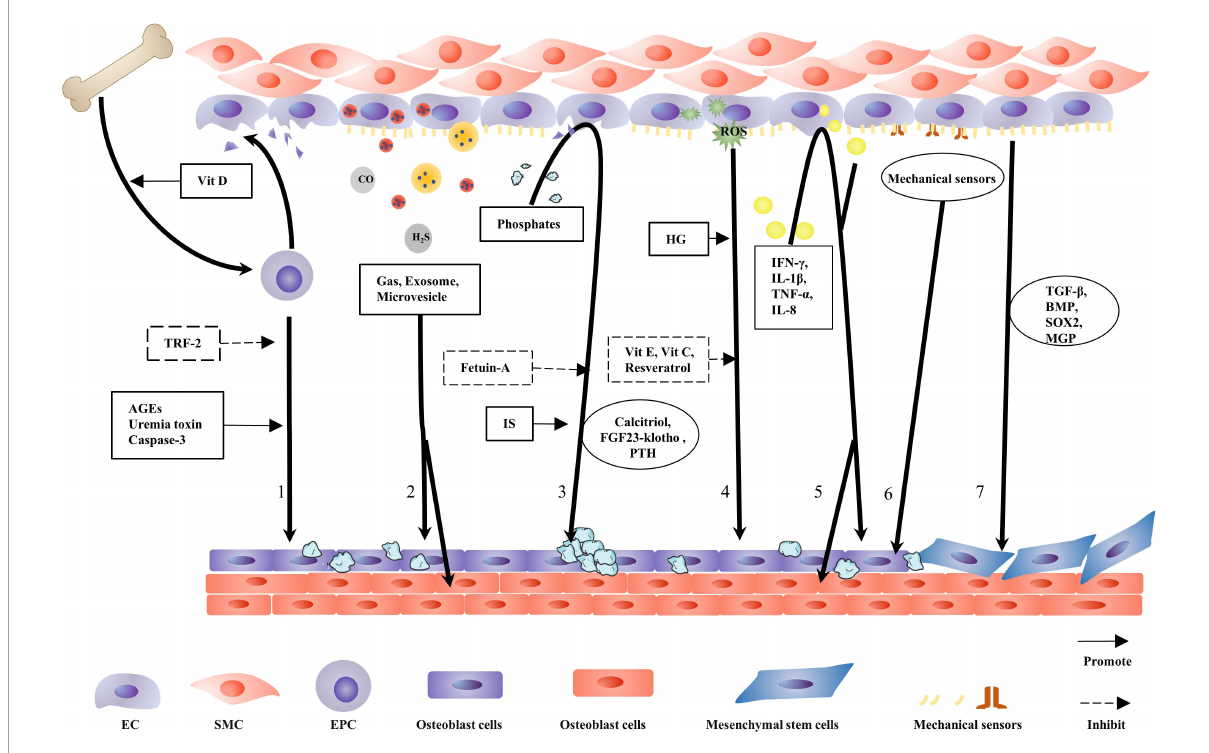
FIGURE2 Contribution of endothelial cells to vascular calcification. When endothelial cells (ECs) are damaged, endothelial progenitor cells (EPCs) are released from the bone marrow into the circulation where EPCs repair the damaged blood vessel wall. This process is facilitated by physiological doses of vitamin D. TRF-2 delays EPC senescence and inhibits vascular calcification (VC). Caspase-3, advanced glycation end products (AGEs), and uremic toxins damage EPC function and transform the repair process into a calcification process. ECs secrete gas, exosome, and microvesicles, with gas directly regulating VC. Exosomes and matrix vesicles (MVs) carry molecules to regulate ECs and vascular smooth muscle cells (VSMCs) osteogenic differentiation. Hyperphosphatemia induce endothelial cell dysfunction and promotes VC; fetuin-A naturally inhibits calcification; and IS aggravates the harmful effects of hyperphosphatemia. The calcitriol–PTH–fibroblast growth factor 23 (FGF23)–klotho axis regulates the metabolism and calcification of calcium and phosphorus. HG is more conducive to reactive oxygen species (ROS) production, and antioxidants alleviate VC. Several inflammatory factors damage ECs to promote VC. Several mechanical receptors are present on the EC surface, detecting changes in blood flow shear stress and determining osteogenic differentiation in the vascular endothelium. ECs that have undergone endothelial-to-mesenchymal transition are disarranged, barrier function is diminished, migration and invasion capabilities are increased, and VC is more likely to